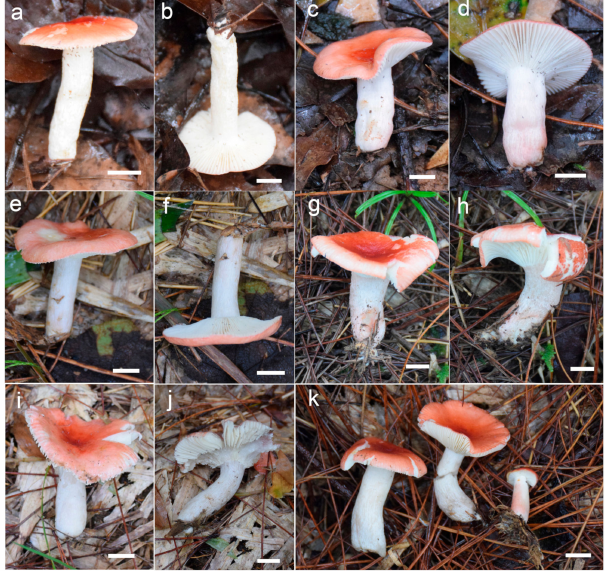
Figure 10. Basidiomata. ( a – k ) Russula rhodochroa . Bars: 10